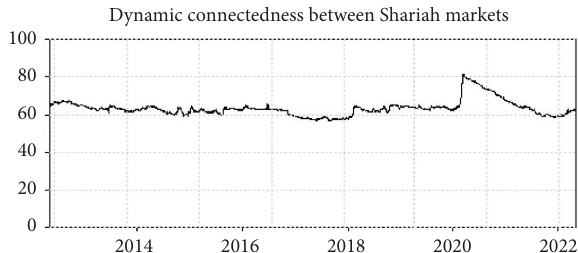
Figure 4: Dynamic spillovers between regional Shariah markets. Notes: time-varying spillover connectedness between regional Shariah markets is presented.